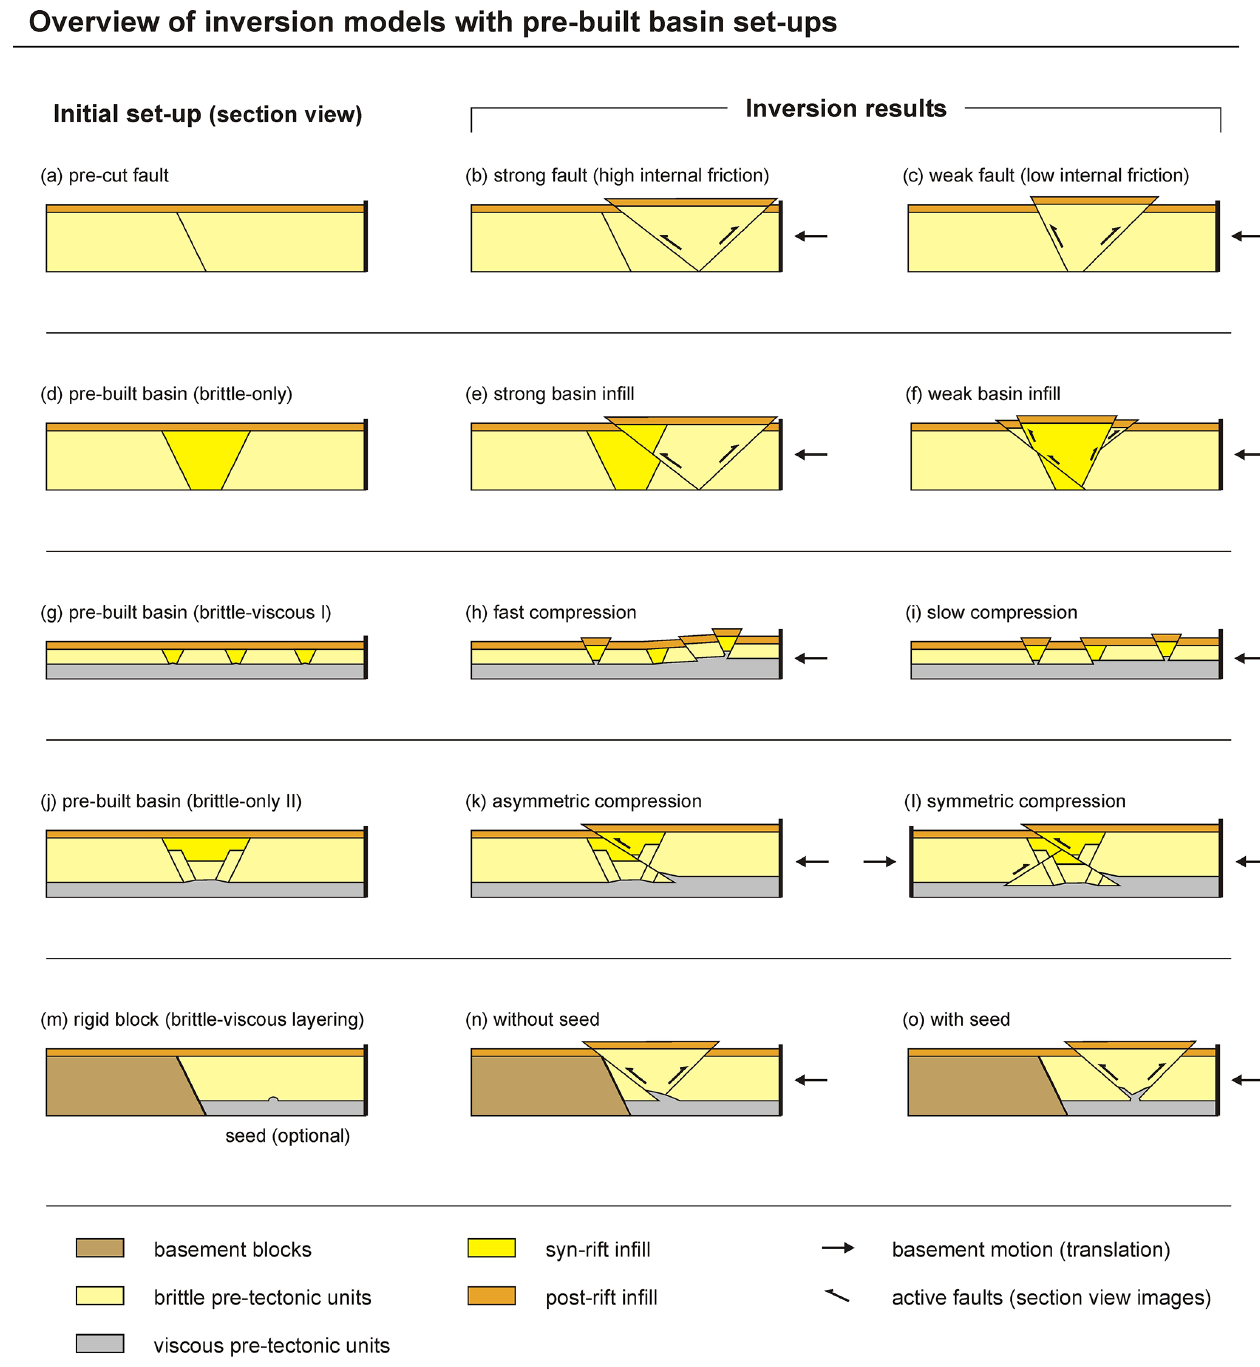
Figure 14. Section-view sketches of representative results from basin inversion models involving a set-up with pre-built basins and faults. (a–c) Inversion of a pre-built fault in a brittle-only layer, which is either relatively (b) strong or (c) weak. (d–f) Inversion of a pre-built basin, containing either a (e) strong brittle basin infill or a (f) weak brittle basin infill. (g–i) Inversion of a brittle–viscous system with thin brittle cover layer and dispersed grabens generated by initial extension with a base plate, during either (h) fast compression or (i) slow compression. (j–l) Inversion of a brittle viscous system with a thick brittle cover and a broad graben generated by initial extension using a base plate, either during (k) asymmetric compression or (l) symmetric compression. (m–o) Inversion of a basin with a viscous basal layer, adjacent to a fixed rigid footwall block: (n) model without seed and (o) with seed. Image inspired by Vially et al. (1994), Letouzey et al. (1995), Panien et al. (2005, 2006a), Marques and Nogueira (2008), Munteanu et al. (2014), and Schori et al. (2021).